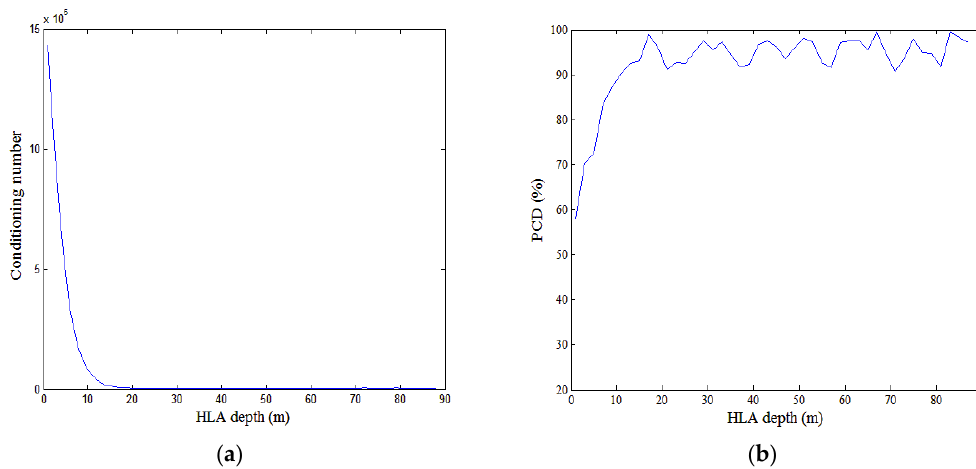
Figure 8. Conditioning number and PCD influenced by the depth of HLA. ( a ) Conditioning number of matrix F versus HLA depth. ( b ) PCD versus HLA depth.